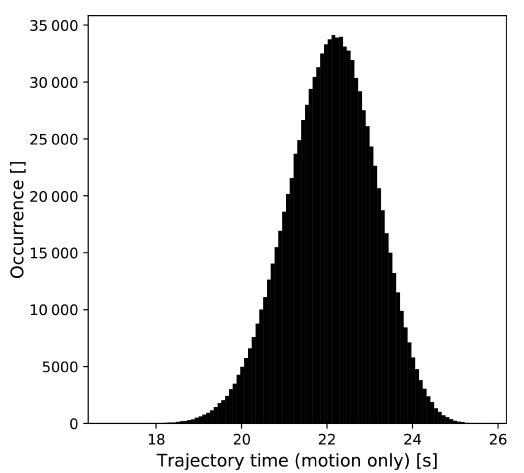
Figure 8. A histogram of motion time for 10 6 different trajectory configurations for the Scottish site. The min, mean, max and stan- dard deviation are 17.15, 22.09, 25.76 and 1.03s,